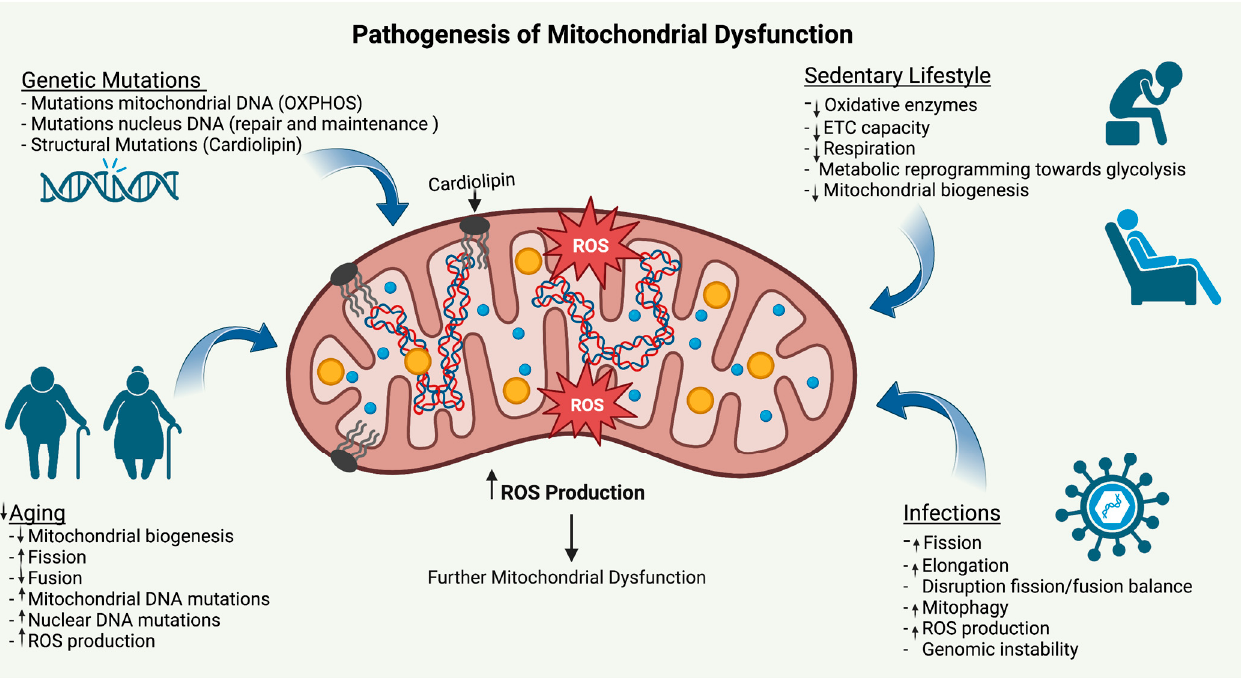
Figure 1. Representation of multiple effectors involved in the pathogenesis of mitochondrial dysfunction. (Up arrows indicate increased and down arrows indicate decreased).